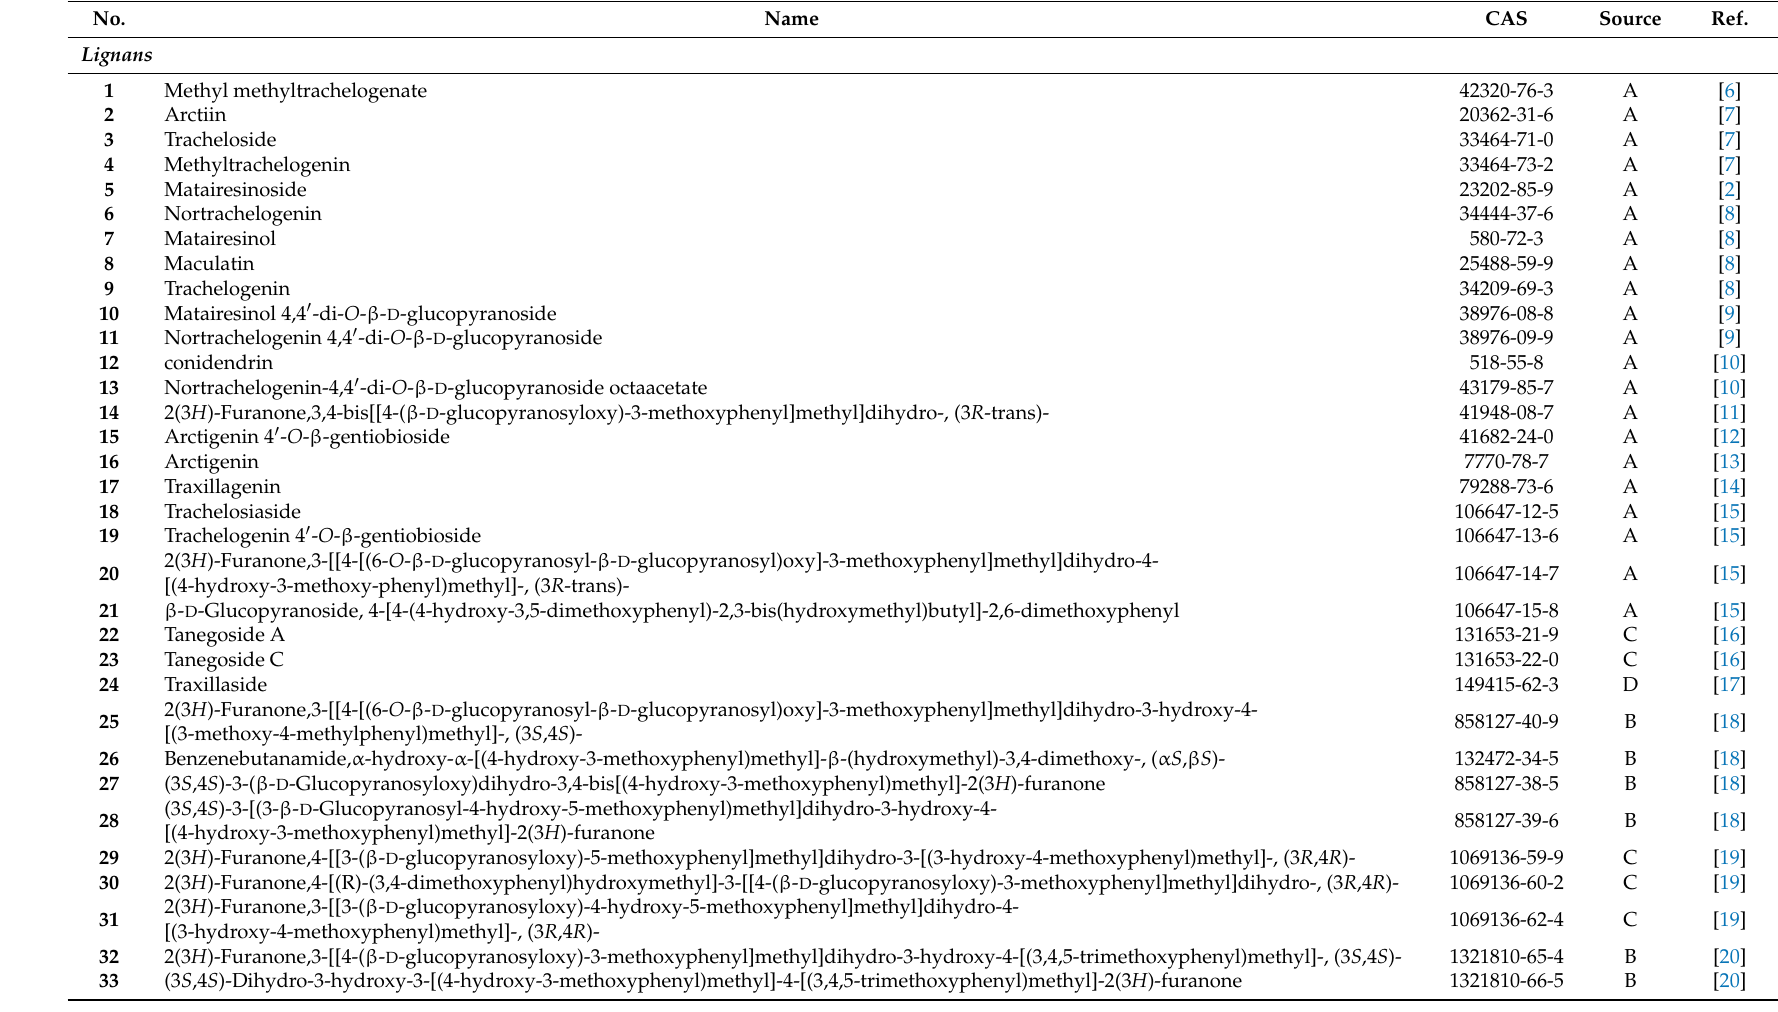
Table 1. Chemical constituents identified from the genus Trachelospermum